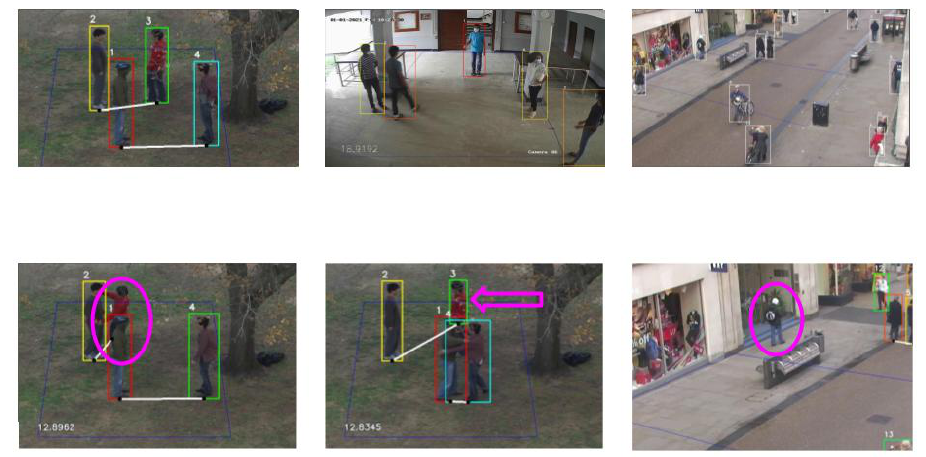
Figure 6. Results of people detection. ( Top row )—cases where the people detection model is successful. ( Bottom row )—instances where people detection is erroneous. Undetected people are marked by the purple oval. The green bounding box (marked by the purple arrow) does not span the full person.